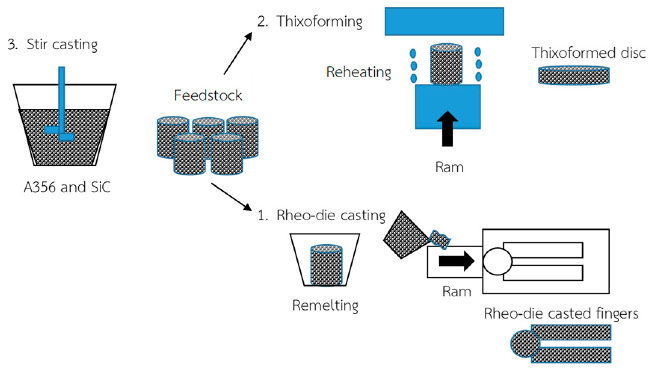
Figure 2. Schematic of the experimental set-up. SiC = silicon carbide.